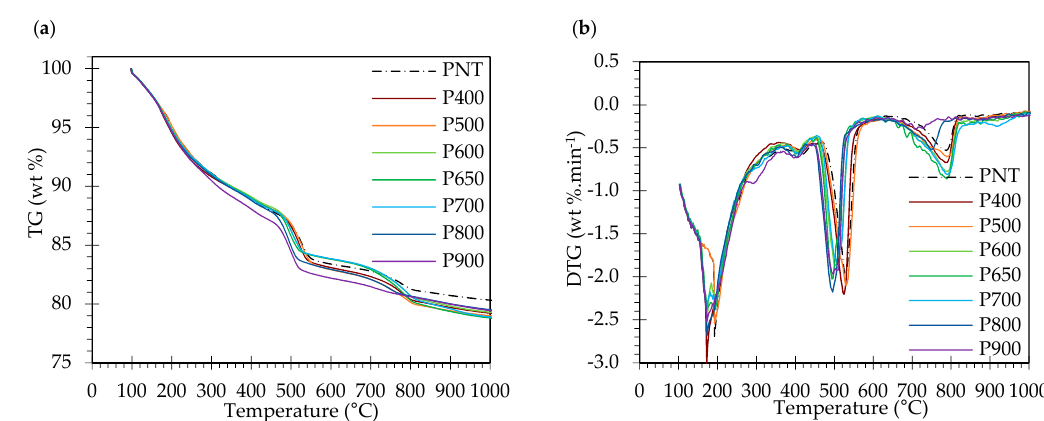
Figure 19. Thermogravimetric analysis: ( a ) TG curves and ( b ) first derivatives (DTG) of PNT and RC pastes at 28 days.